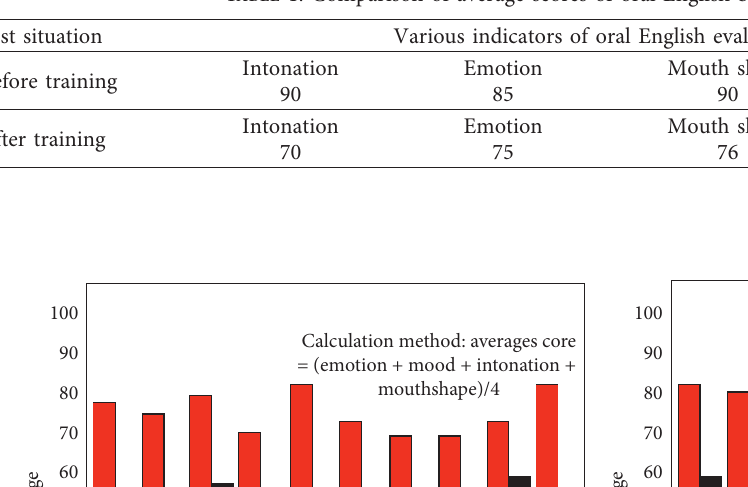
Table 1: Comparison of average scores of oral English before and after training.